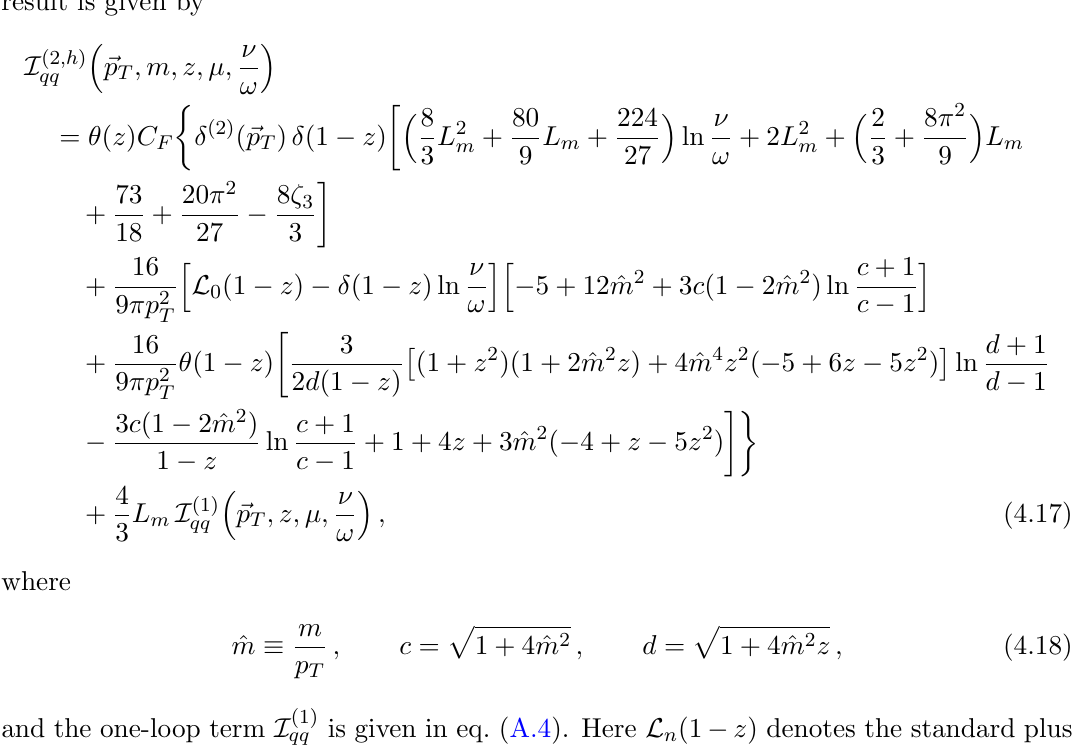
Figure 9 . Secondary massive quark corrections for the light-quark beam function at addition, also the wave-function renormalization correction and the mirror diagrams for (b) and (c) have to be